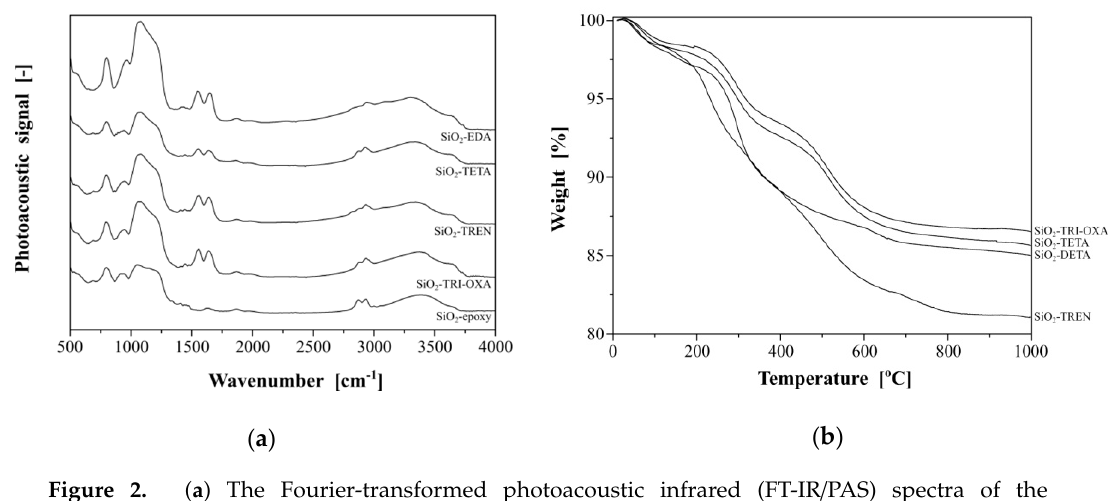
Figure 2. ( a ) The Fourier-transformed photoacoustic infrared (FT-IR / PAS) spectra of the PAMAM-modified hybrid materials; ( b ) the thermogravimetric analysis of the synthesized hybrid materials.